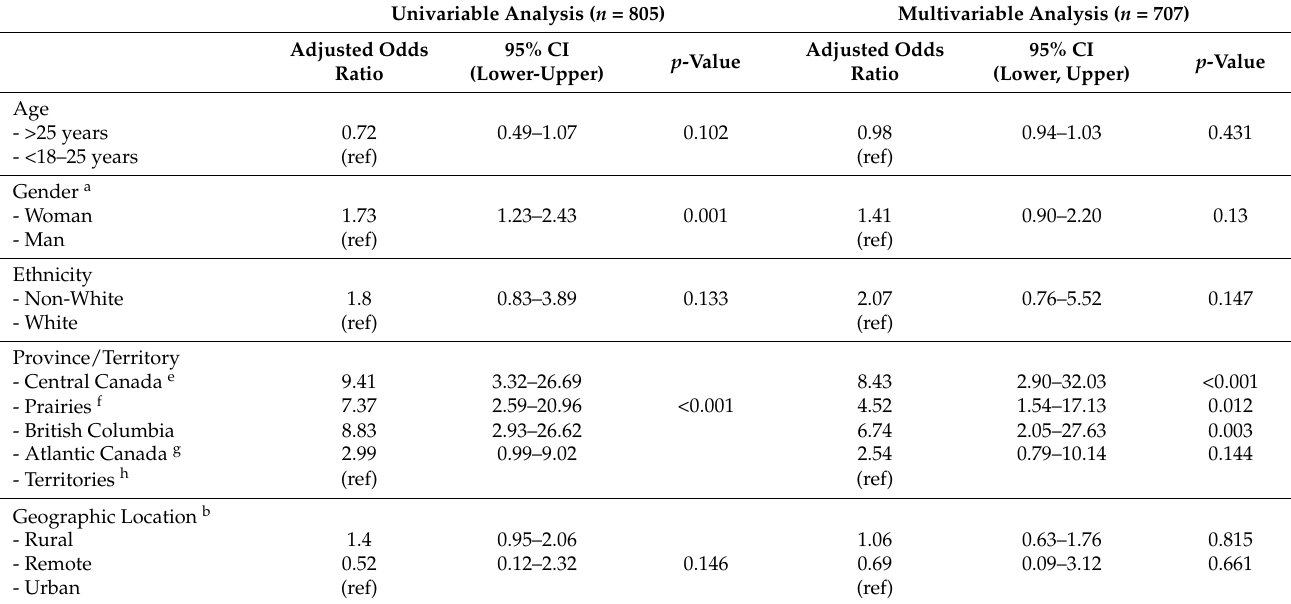
Table 2. Factors associated with a negative impact of the COVID-19 pandemic on cancer care